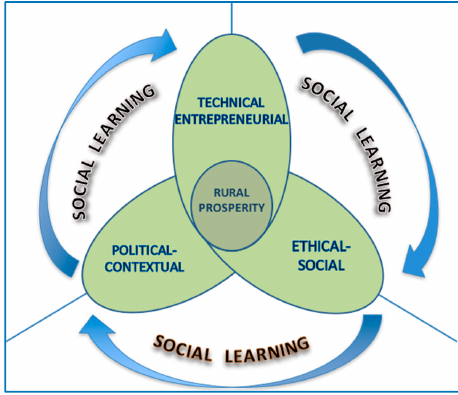
Figure 5. Dimensions of the Working With People (WWP) Model [49].